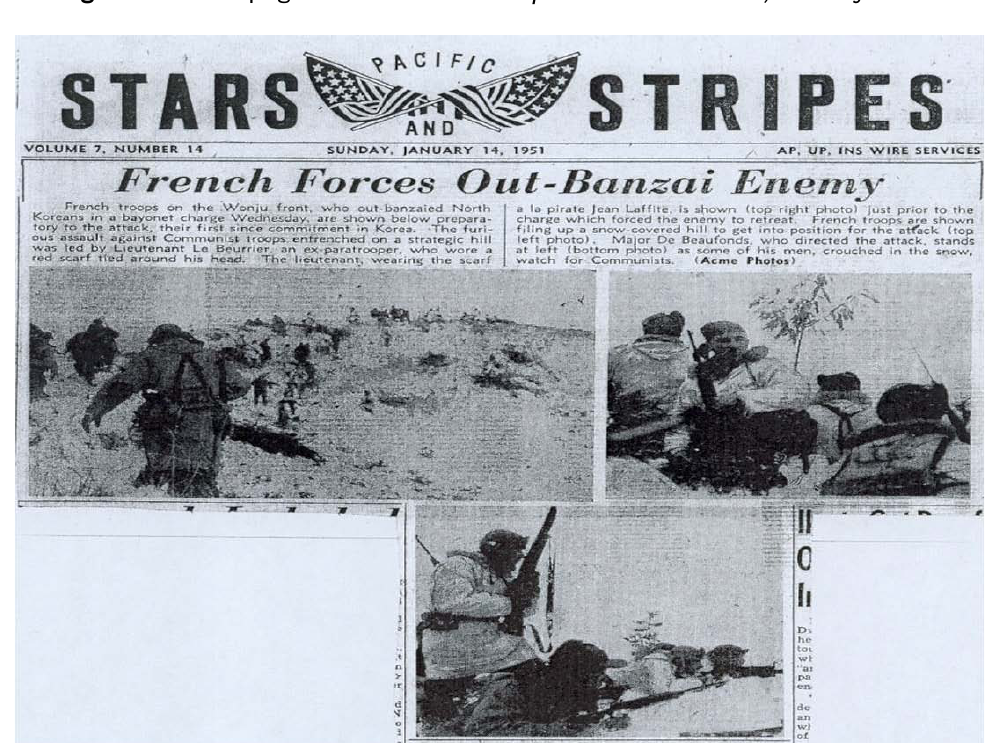
Figure 1. Front page of the Stars & Stripes Pacific Edition, January 1951.